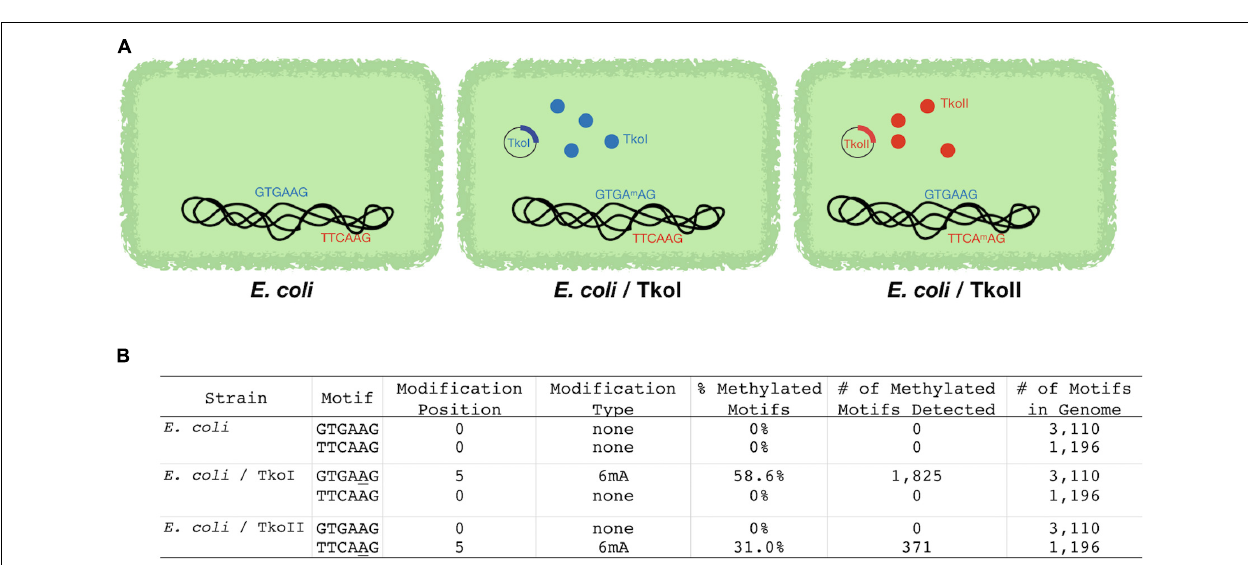
FIGURE 3 | Escherichia coli strains expressing TkoI and TkoII demonstrate heterologous MTase activities in vivo . E. coli was transformed with an empty plasmid or plasmids encoding TkoI (blue) or TkoII (red) R-M systems (schematically illustrated in A ). (B) PacBio SMRT sequencing was used to sequence genomic DNA from each strain. After sequencing, PacBio Modification and Motif software identified sequence motifs that were modified in each strain.